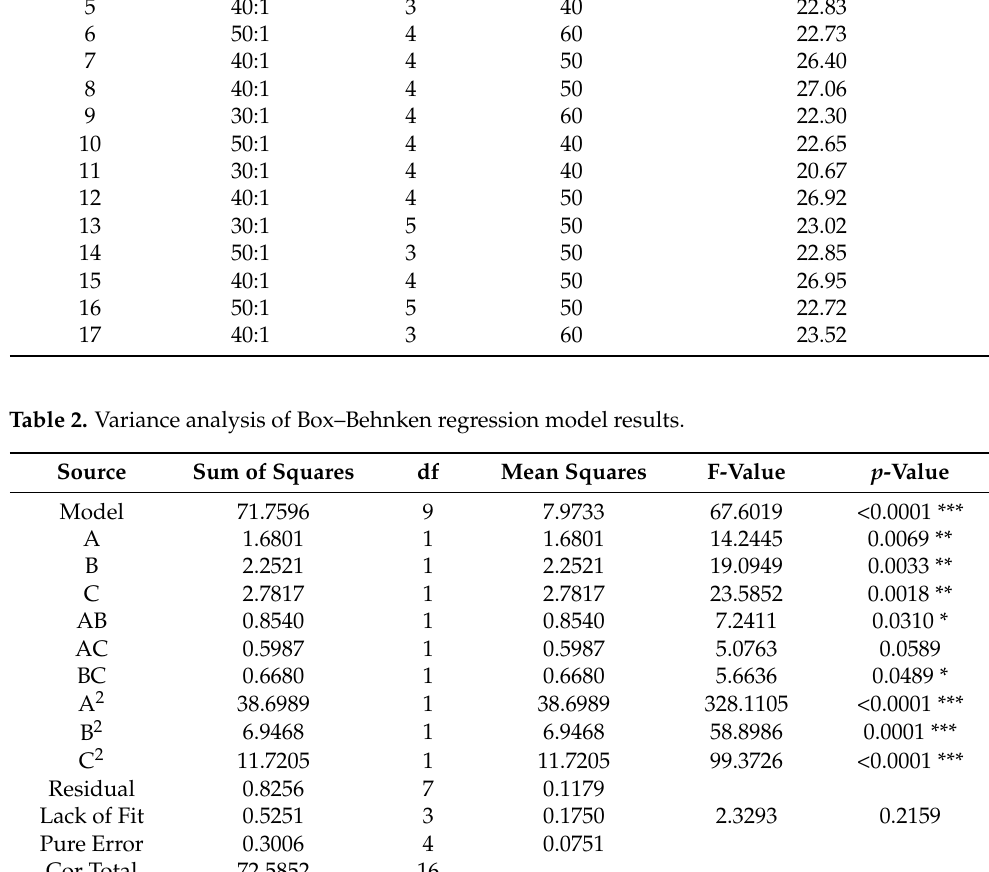
of the multivariate regression fitting, the relationship between the response variables (flavonoids content of NHE, Y) and the quadratic regression equation is shown in the formula as follows: